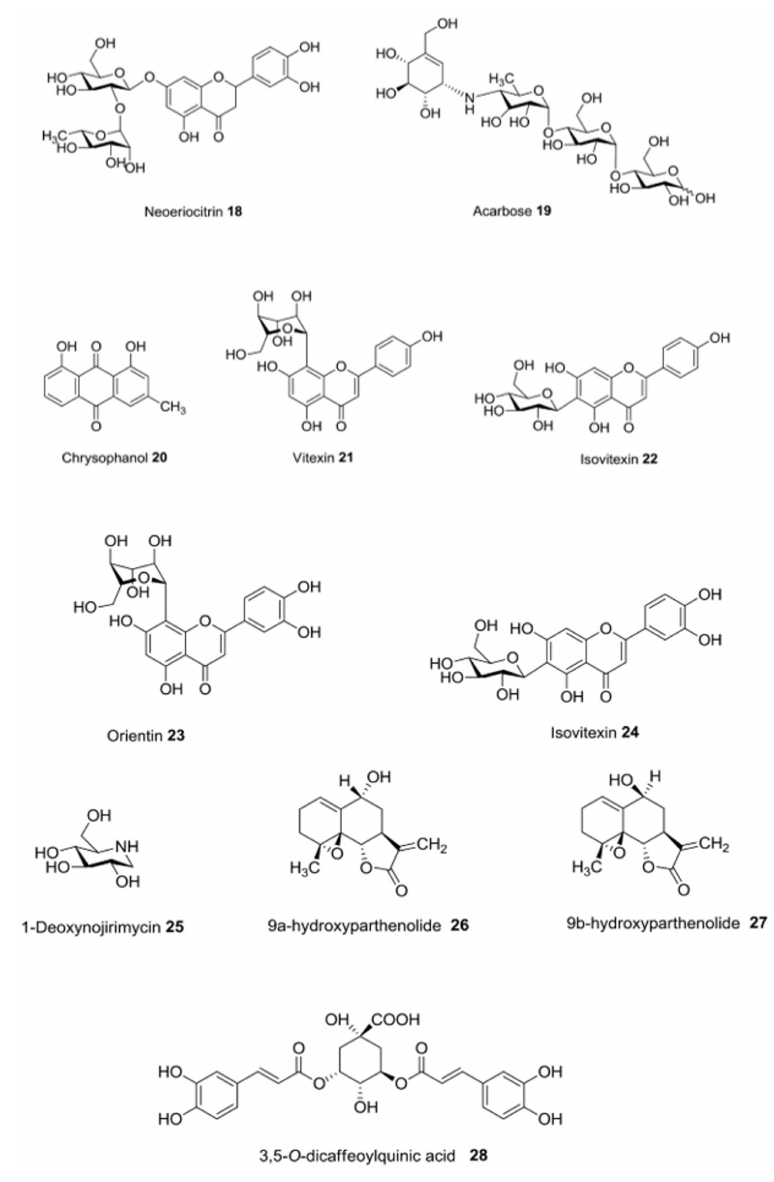
Figure 2. Natural compounds with hypoglycemic properties